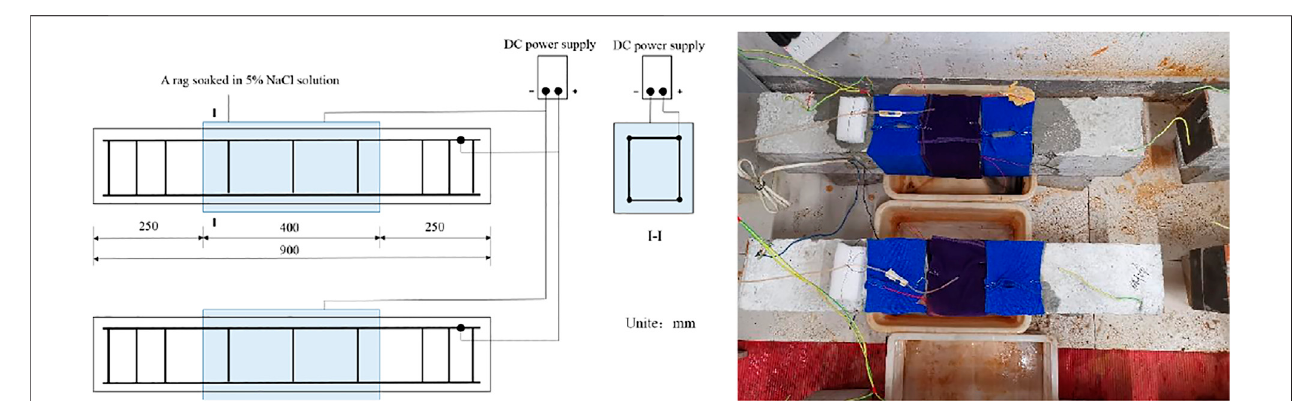
FIGURE 3 | The rust condition of the specimen when electri fi